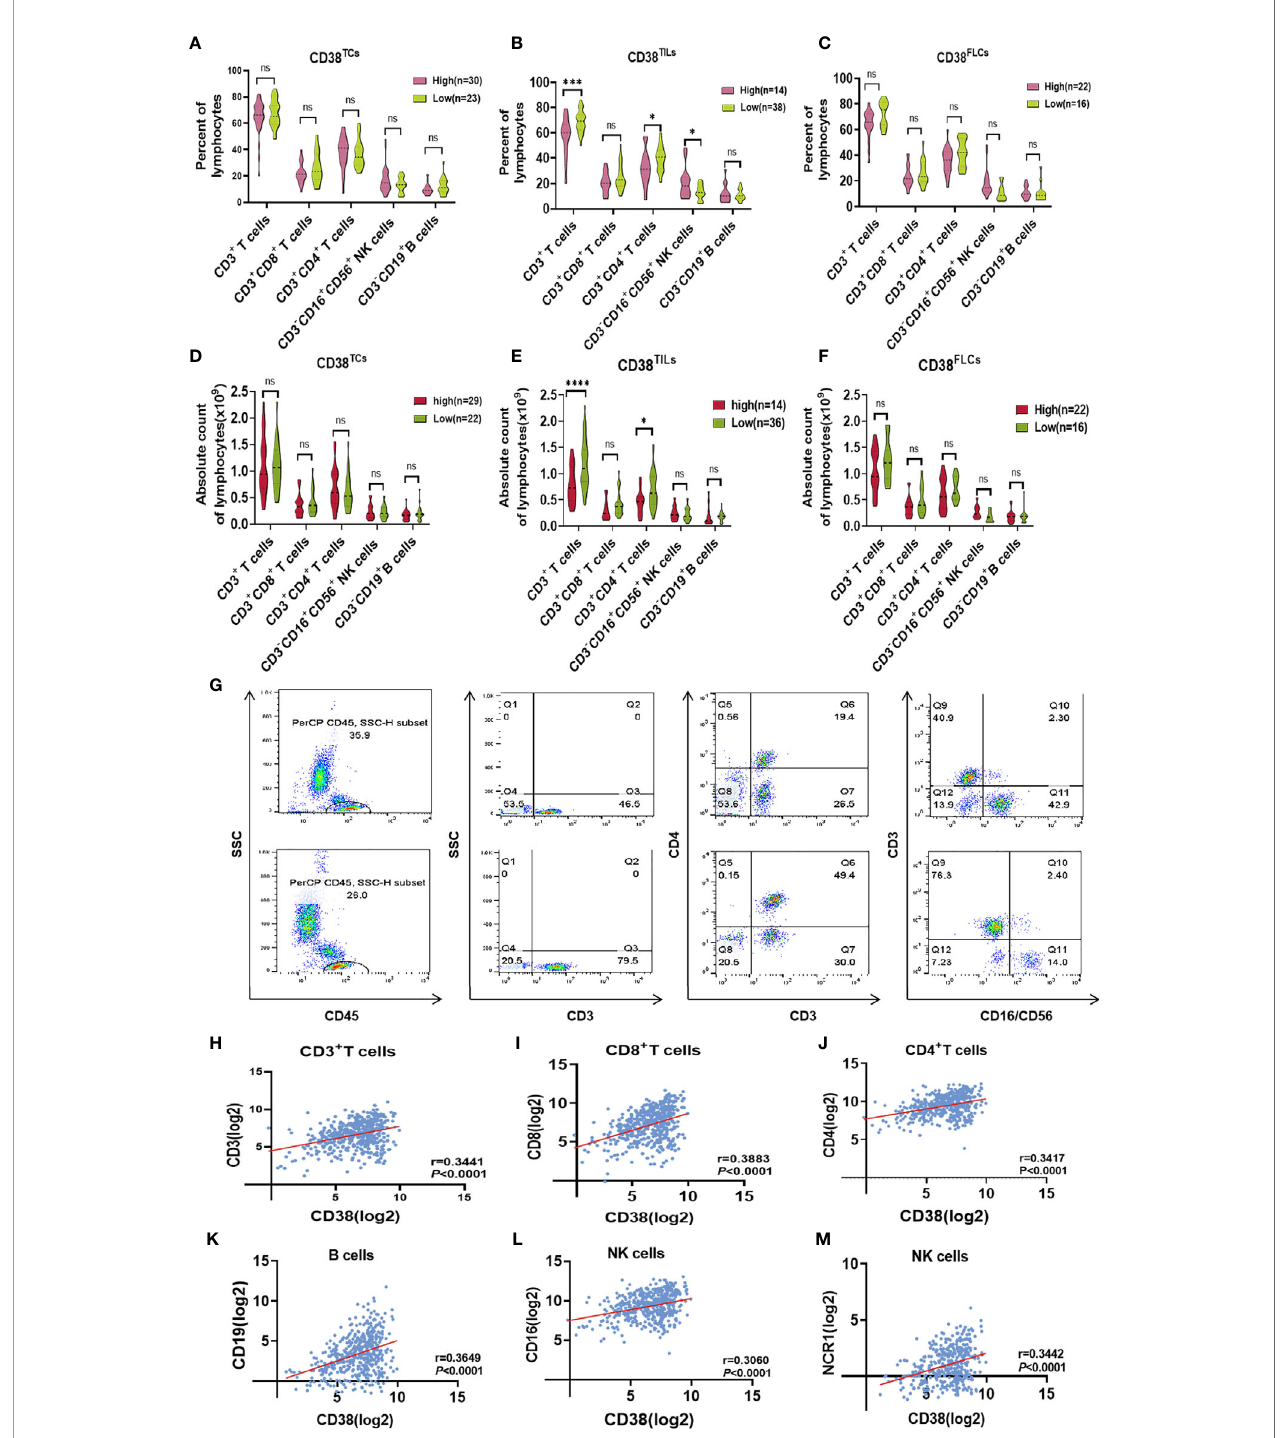
FIGURE 4 | The change of lymphocytes subset in PBMC and tissue of OSCC patients according to CD38 level. The radio of lymphocytes subset of PBMCs in patients with distinct expression of CD38 TCs (A) , CD38 TILs (B) , CD38 FLCs (C) . The absolute count of lymphocytes subset of PBMCs in patients with distinct expression of CD38 TCs (D) , CD38 TILs (E) , CD38 FLCs (F) . (G) : Flow-cytometry dot plots show the strategy for gating lymphocytes, CD3 + T cells, CD3 + CD4 + T cells and CD3 − CD16 + CD56 + NK cells with distinct expression of CD38 TILs. Correlation between CD38 and CD3 + T cells (H) , CD3 + CD8 + T cells (I) , CD3 + CD4 + T cells (J) , B cells (K) , NK cells (L, M) in fi ltration in HNSCC using cBioportal database. *,***,**** represented that differences were considered statistically signi fi cant with P < 0.05, P < 0.001 P < 0.0001 respectively, and ns reprented no statistical